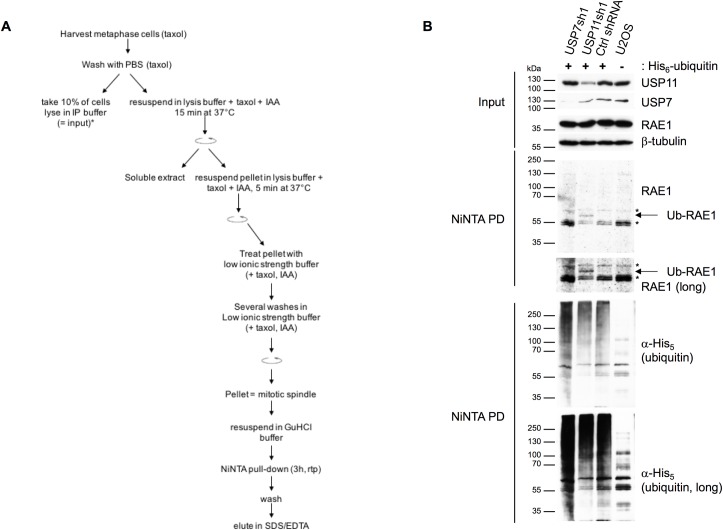
Ablation of USP11 increases ubiquitination of RAE1 on the mitotic spindle.(A) Schematic representation of the mitotic spindle fractionation followed by NiNTA pull-down of His6-ubiquitinated proteins. (B) U2OS cells stably expressing His6-ubiquitin were transduced with a control shRNAs or shRNAs targeting USP7 or USP11 transcripts. A U2OS cell line that lacks ectopic expression of His6-ubiquitin was used as negative control. After 24h treatment with nocodazole mitotic cells were harvested by shake off, released for 90 min in complete medium supplemented with 5 μM MG132, and treated briefly with taxol (3 min) before harvesting, fractionation was done as shown in (A). Samples (input and NiNTA pull-down) were separated on a 7.5% SDS-PAGE gel before transfer onto nitrocellulose membrane. Antibodies used are indicated to the right of each blot; *, indicate non-specific bands.